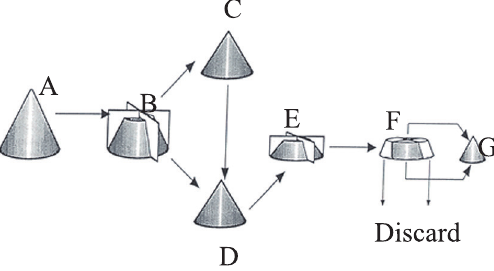
Fig. 2 Coning and quartering as described by Davies (2009).